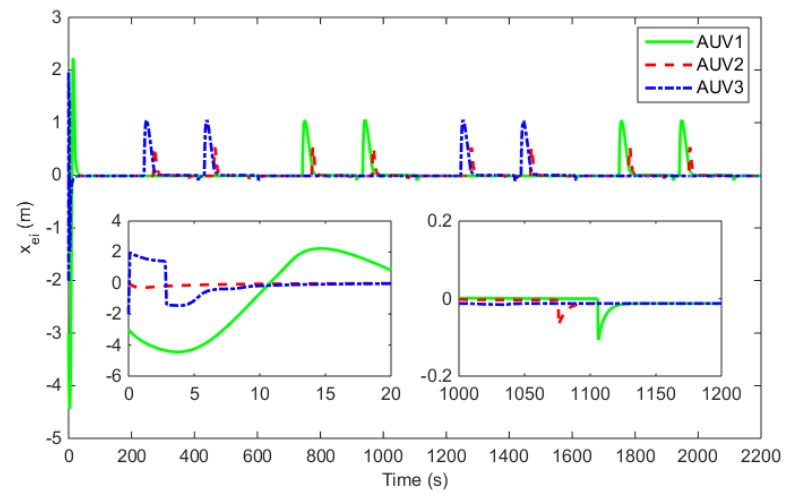
Figure 7. Along-maneuvering errors of three AUVs.